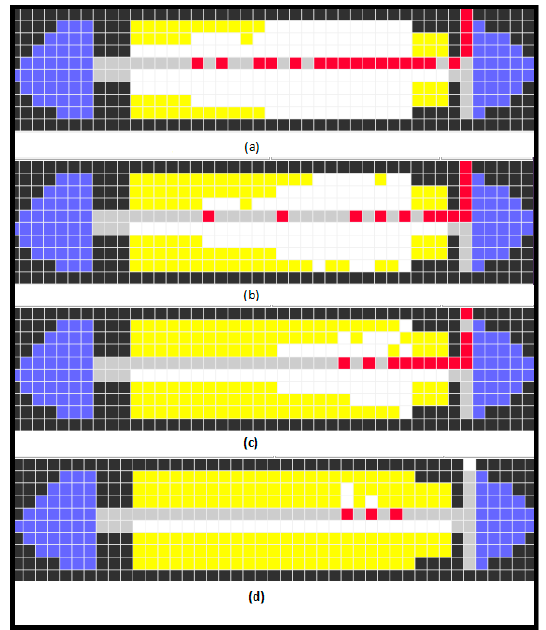
Figure 29. Efficient strategy.